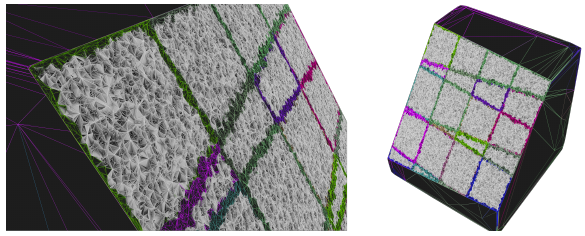
Figure 4. 1M random points triangulation on a 3x3x3 grid.